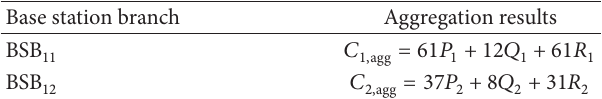
Table 3: The encryption in inner-cluster data aggregation. Cluster nodes